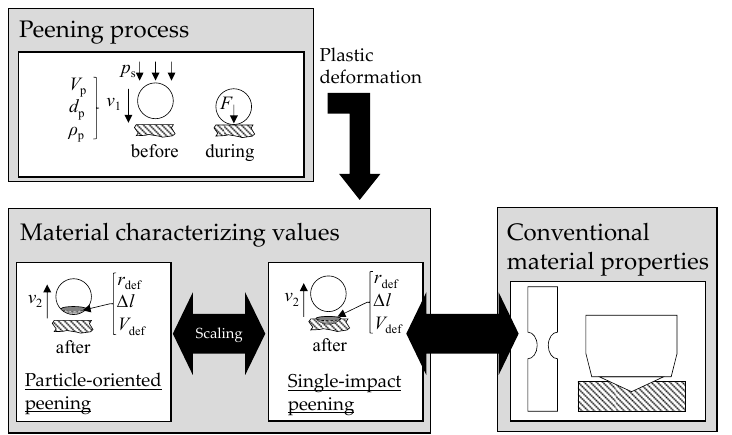
Figure 1. Comparison of the plastic deformation due to a particle-oriented peening process and a conventional shot peening process with a single impacting particle (single-impact peening).